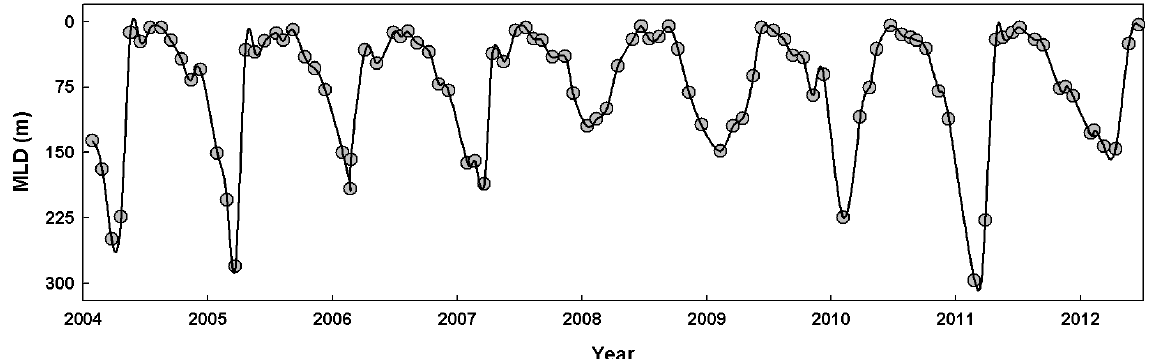
Figure 3. Mixed layer depth (MLD) during the sampling period at the BATS